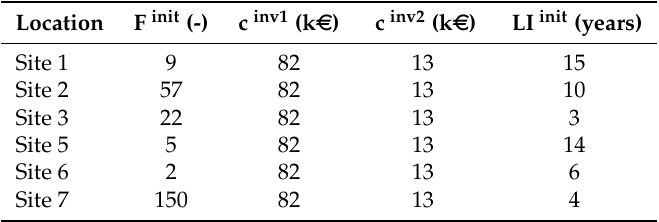
Table 3. Existing cooling and their investment